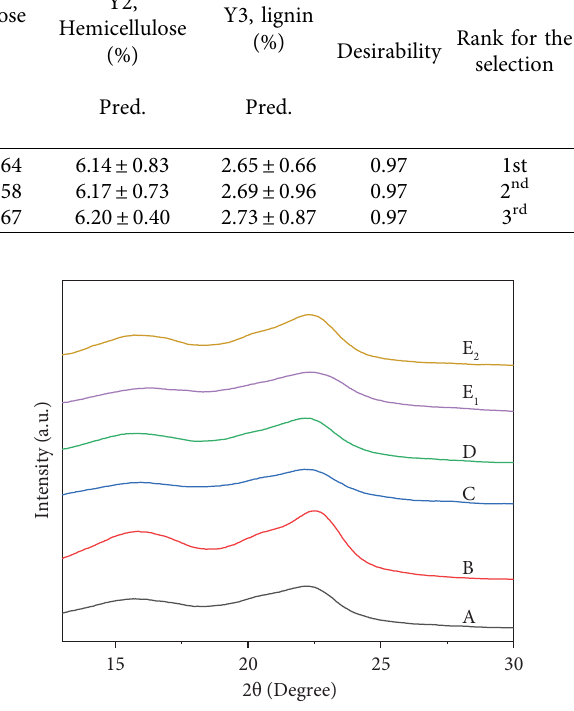
Table 3: Description of the first three optimized predicted solutions of the RSM quadratic model design matrix for the second-step bleaching treatment. Model parameter Yields selectionFactors used in ANOVA